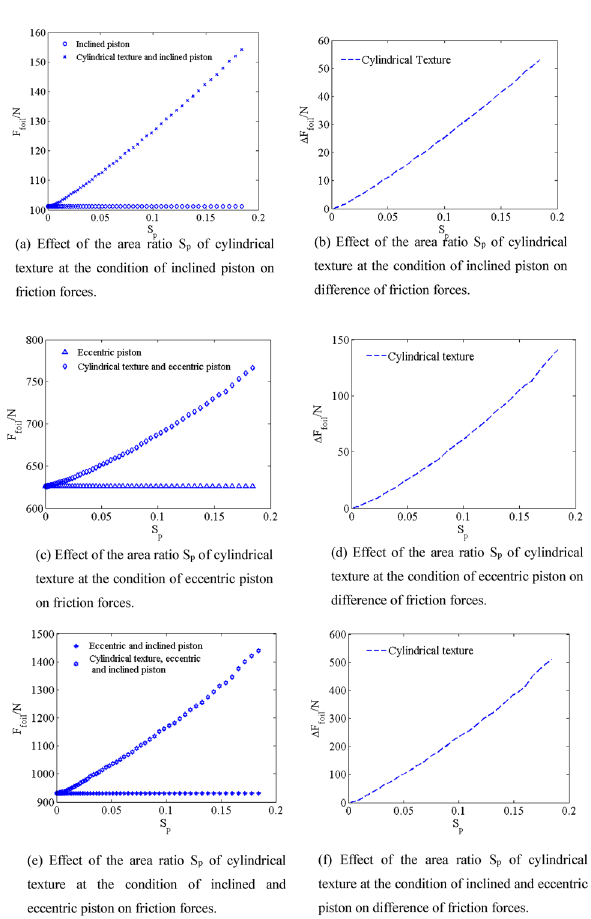
Figure 13. Effect of the area ratio S p of cylindrical texture at different conditions on friction